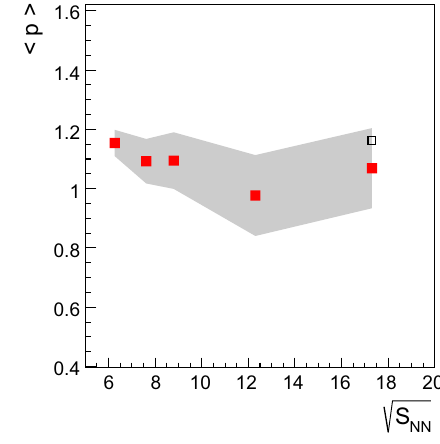
Fig. 38 Mean proton multiplicities produced in inelastic p + p interac- tions as a function of collision energy. Filled red squares depict results from this analysis, the open black square shows the measurement of NA49 [12]. The dominating uncertainty of the NA61/SHINE measure- ments is systematic and is indicated by the shaded